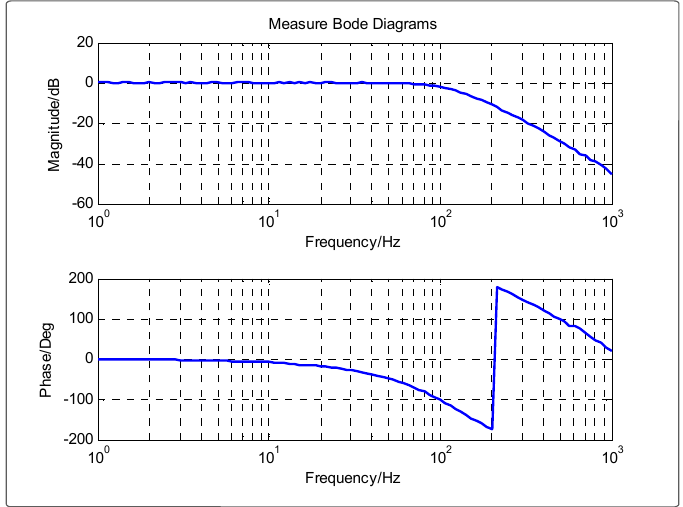
Figure 11. The closed-loop bode response of the velocity.